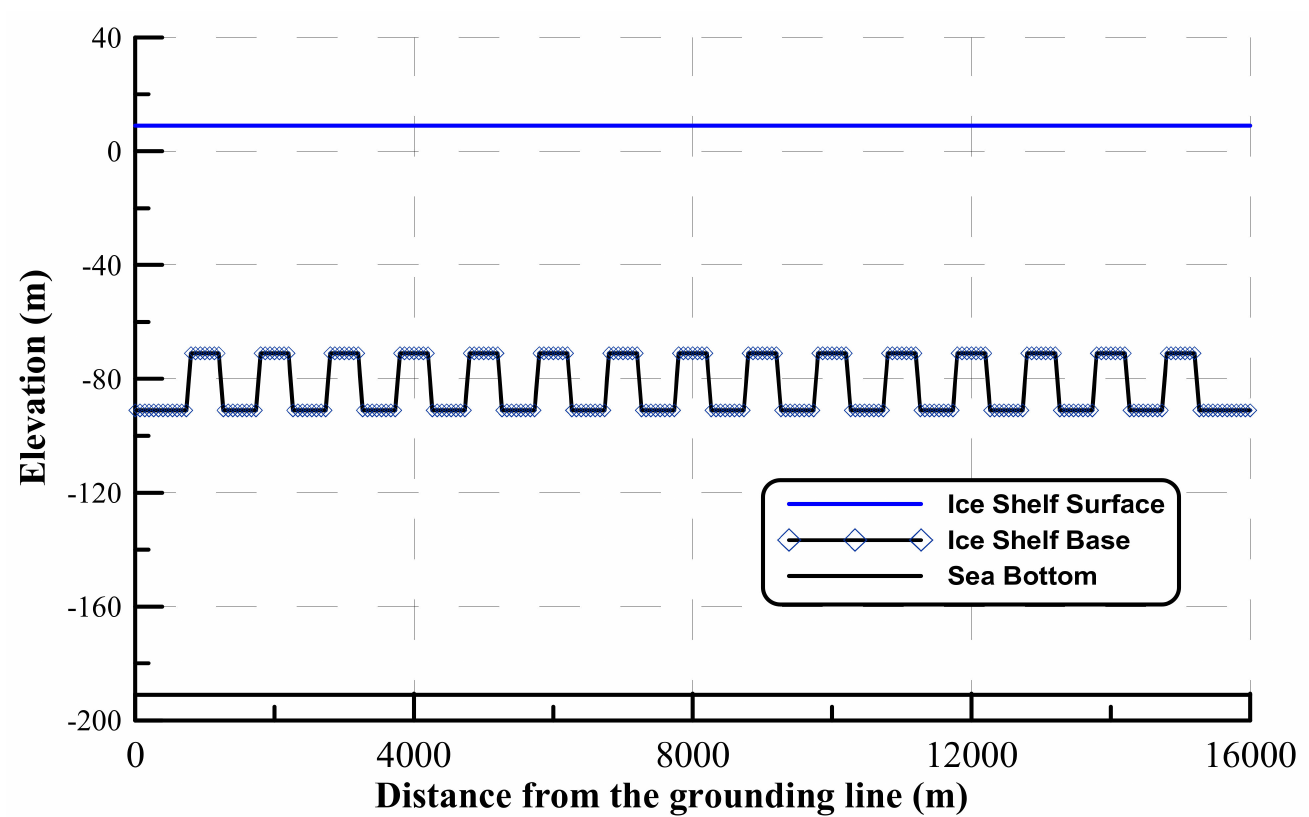
Figure 1. The crevasse-ridden ice-shelf geometry and the cavity geometry that are considered in the numerical experiments. Spatial periodicity ( ∆ l cr ) of the crevasses is equal to 1 km. The width of the crevasses ( w cr ) is equal to 500 m, and the penetration depth ( d cr ) of the crevasses is equal to 20